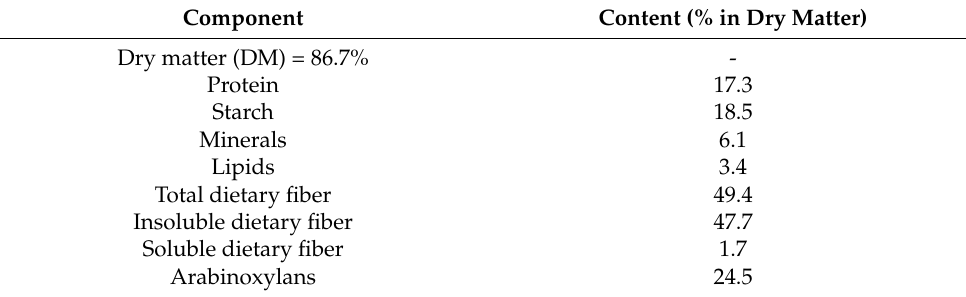
Table 1. Chemical composition of wheat